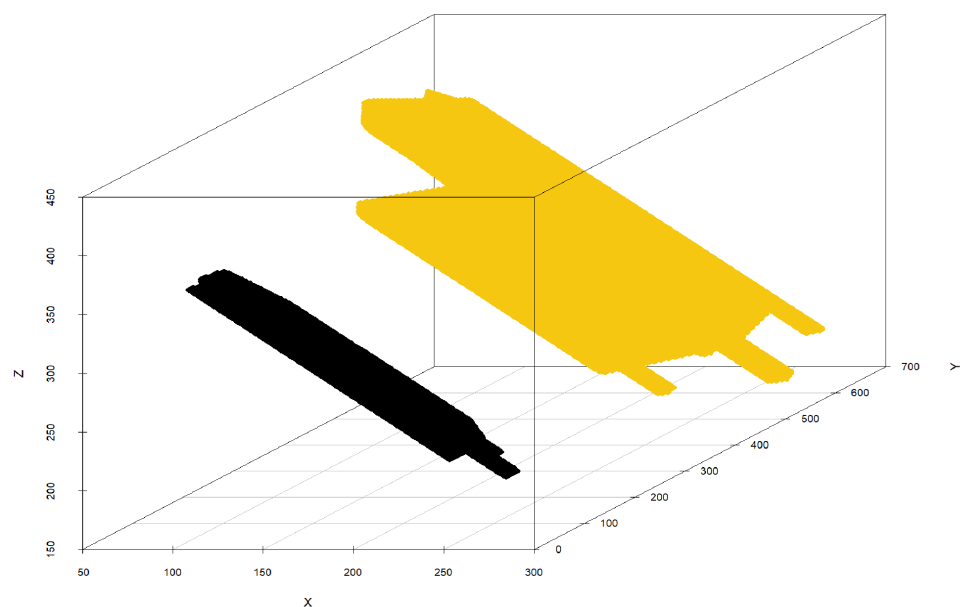
Figure 12. Plot of K-means clustered data of two separate